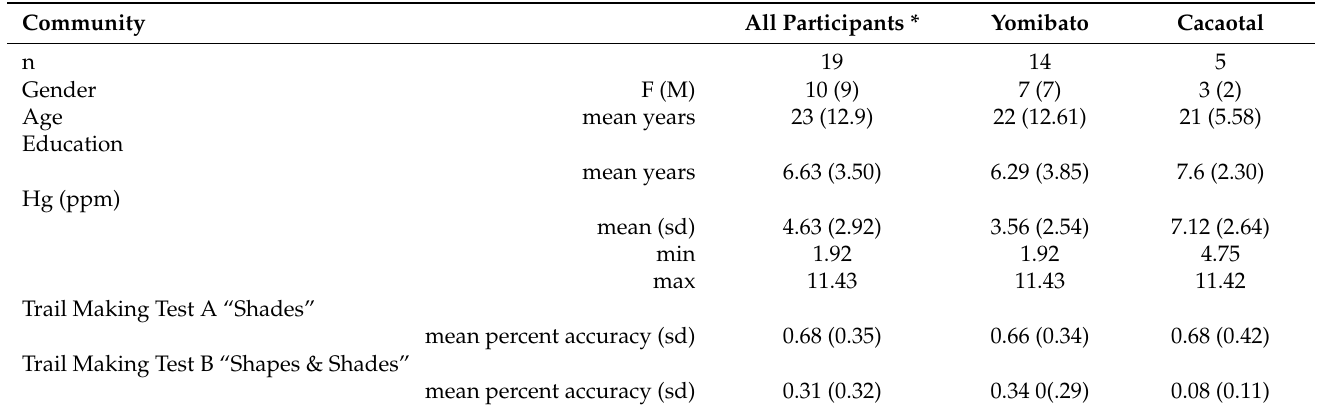
Table 2. Summary Statistics for Trail Making Test Sample Pilot Test.